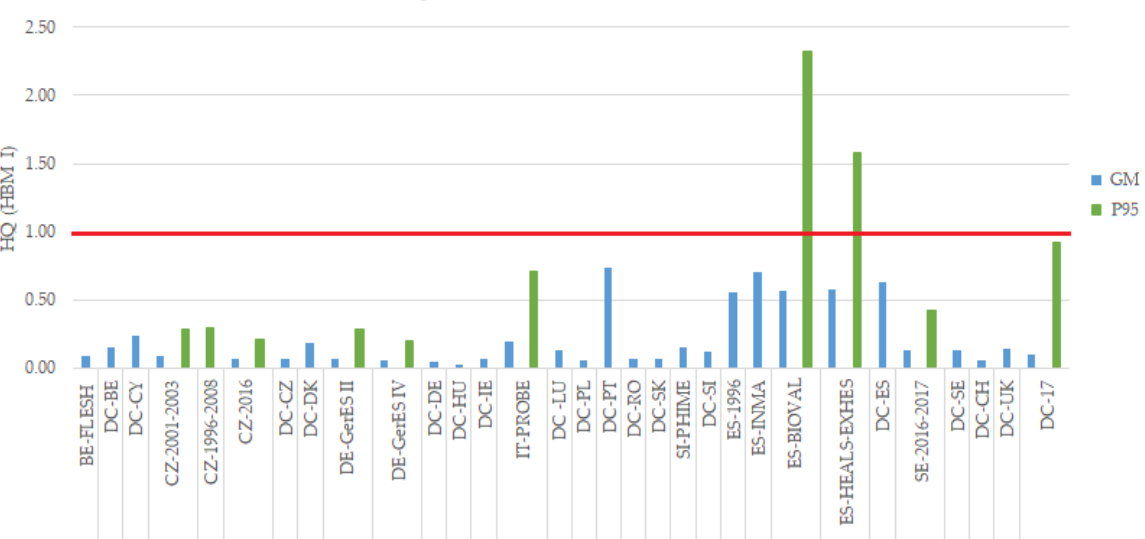
Figure 2. HQ for the GM and P95 of total Hg blood levels of the HBM European studies in chil- dren/adolescents (3–17 years old). DEMOCOPHES Study (DC). Note: MeHg levels in the case of FLESH study.